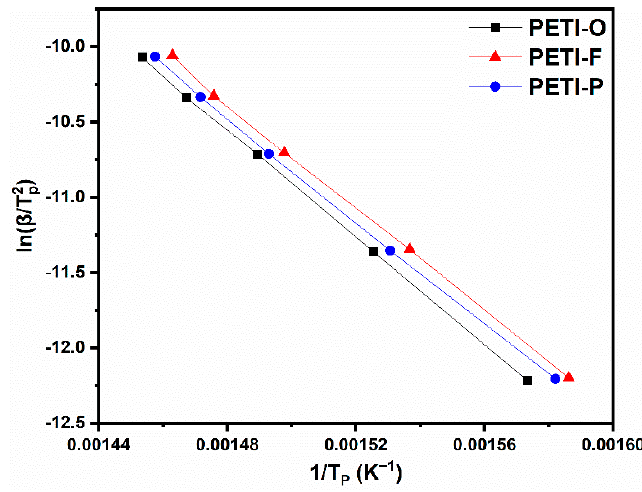
Table 3. Kinetic parameters of PETI-O, PETI-F and PETI-P.